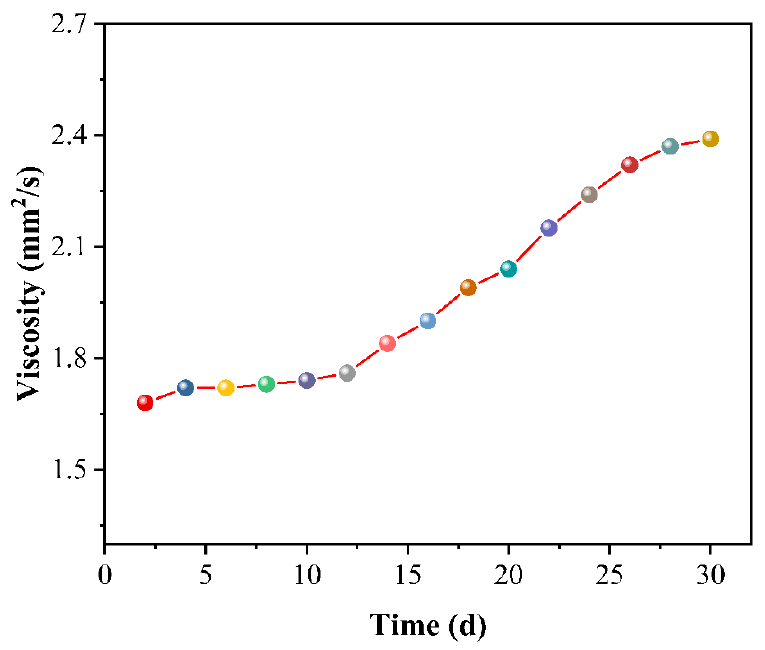
Figure 1. Time dependence of the sol viscosity.